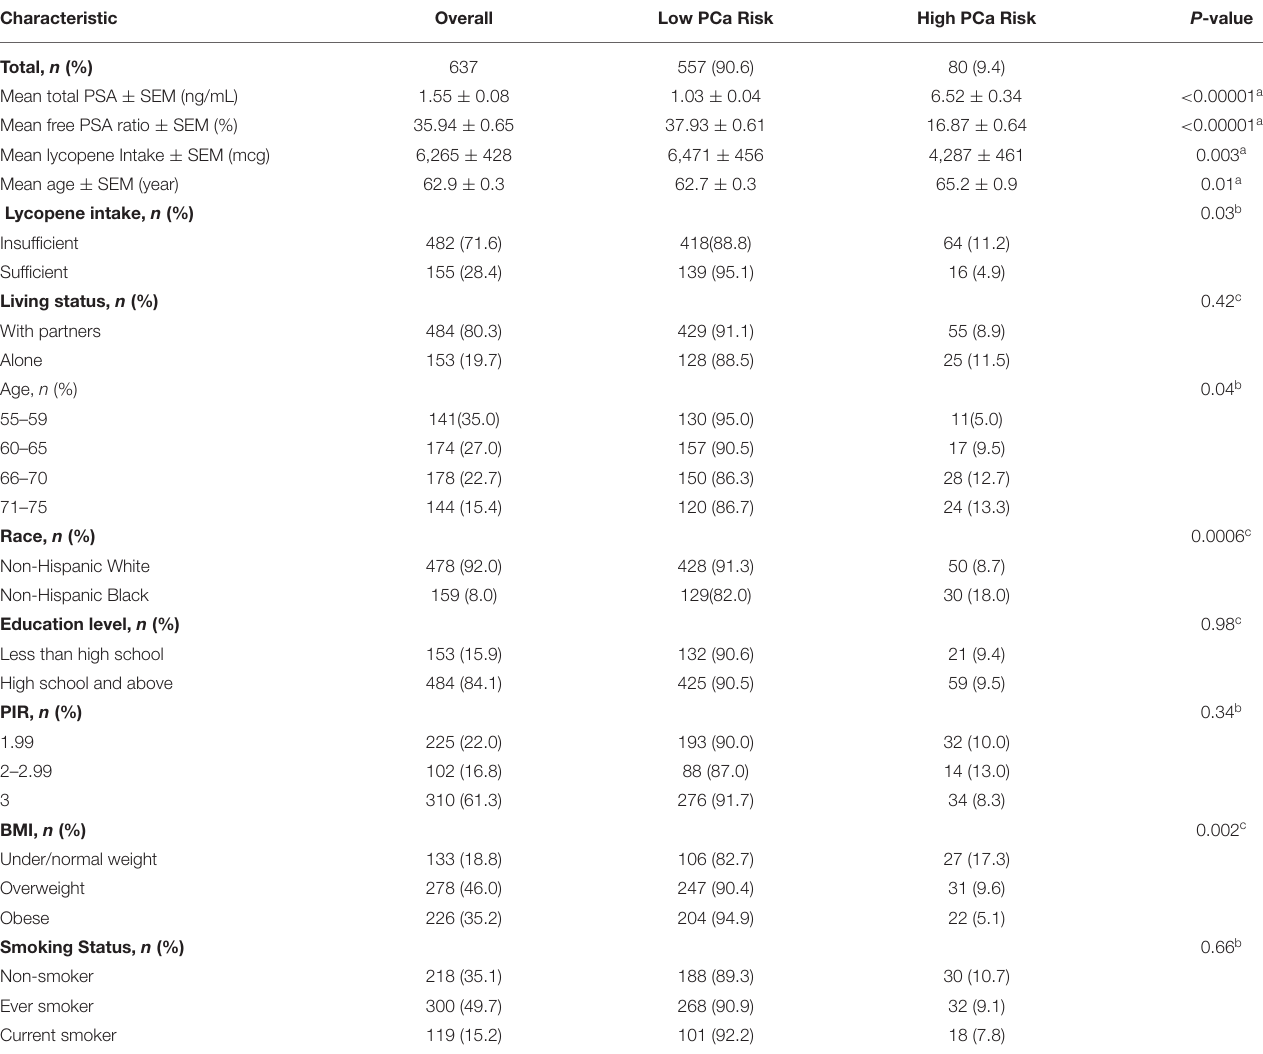
TABLE 1 | Characteristics of 637 male adults with different PCa risk using NHANES 2003–2010 Data.